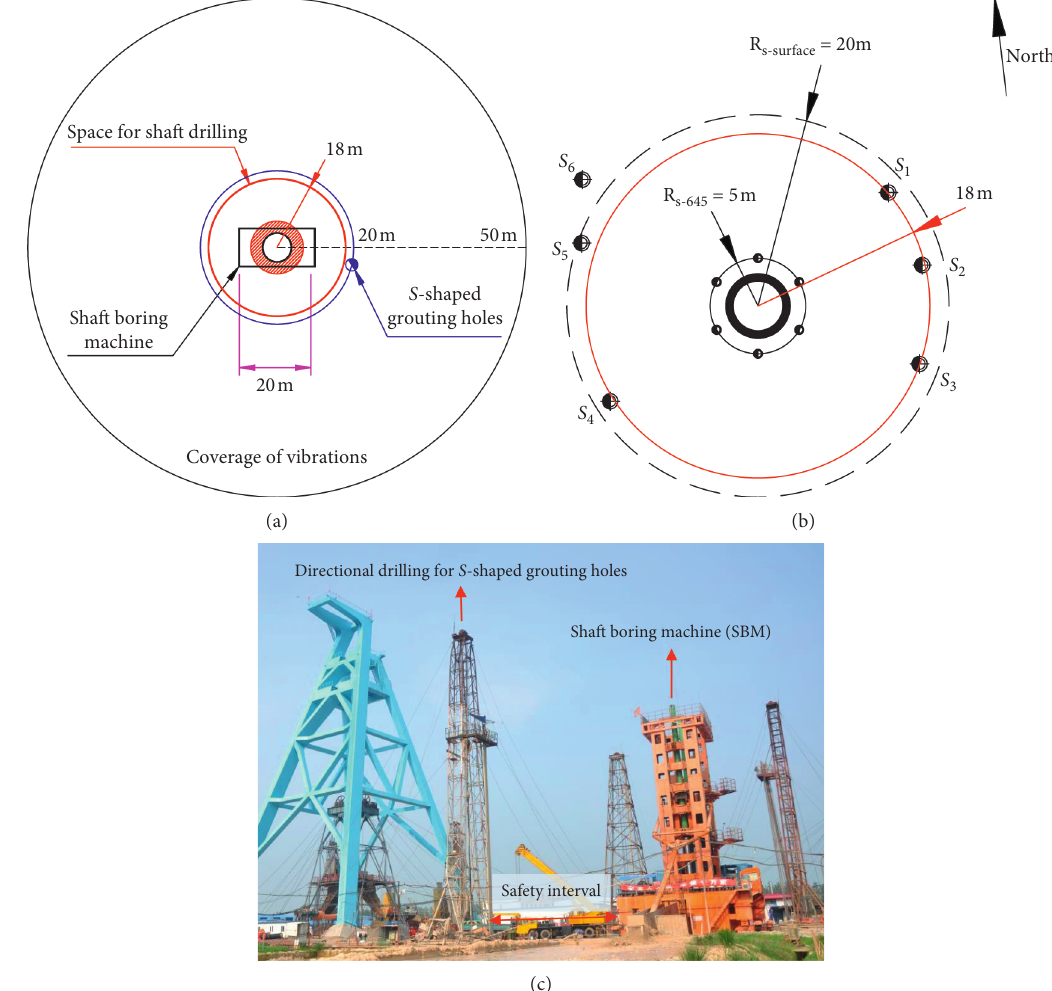
Figure 6: Layout of S -shaped grouting holes during simultaneous operations. (a) Grouting holes spaced outside the SBM. (b) Layout of grouting holes on the surface. (c) Equipment arrangement on the